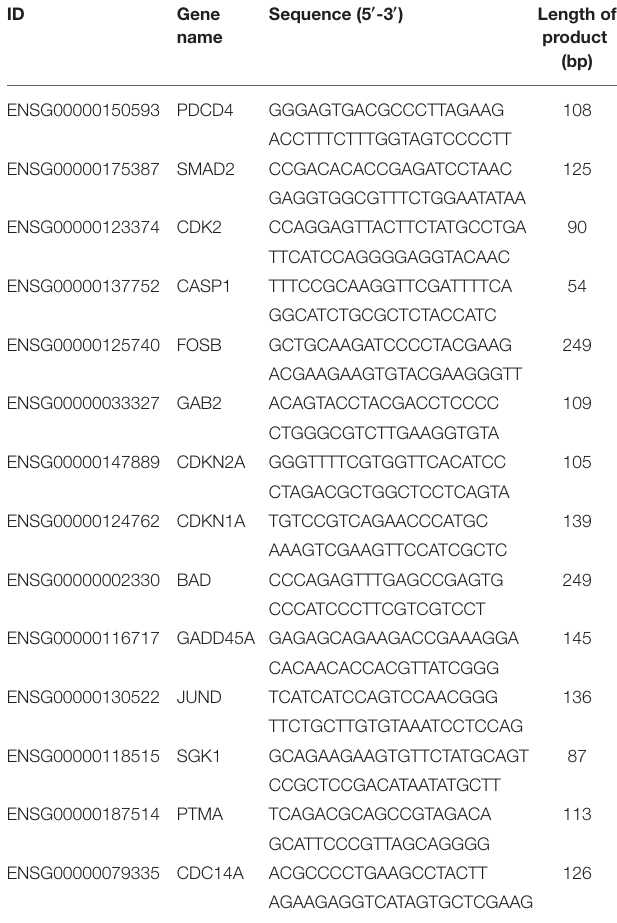
TABLE 1 | List of primers used in the present